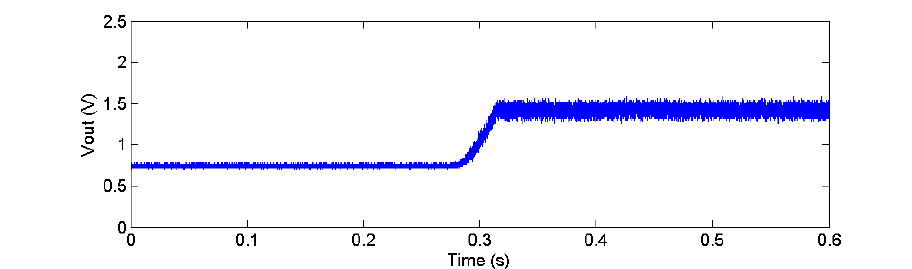
Figure 10. A demonstration of automatic correction for a single channel in stop mode.